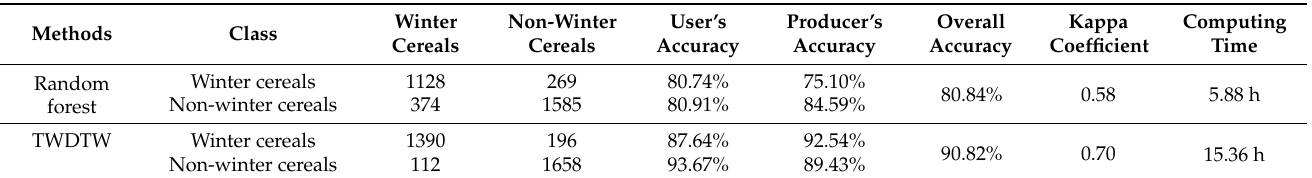
Table 3. The confusion matrix of the winter cereal maps for 32 countries in Europe in 2018 using the random forest and TWDTW method, respectively.